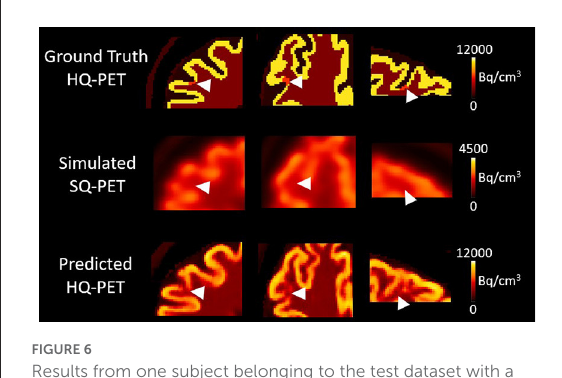
FIGURE6 Results from one subject belonging to the test dataset with a simulated right frontal hypometabolic lesion with a volume of 22 mm 3 . First column, transverse view, second column, coronal view, third column, sagittal view centered on the lesion. The relative lesion activity was 0.6 in the ground-truth high-quality (HQ) PET, 0.95 in the simulated standard-quality (SQ) PET, and decreased to 0.75 in the predicted HQ PET. Arrowheads indicate the location of the simulated lesion. Images are displayed using radiological conventions (subject’s left on the right). Bq, Becquerel cm 3 : centimetres cubed .